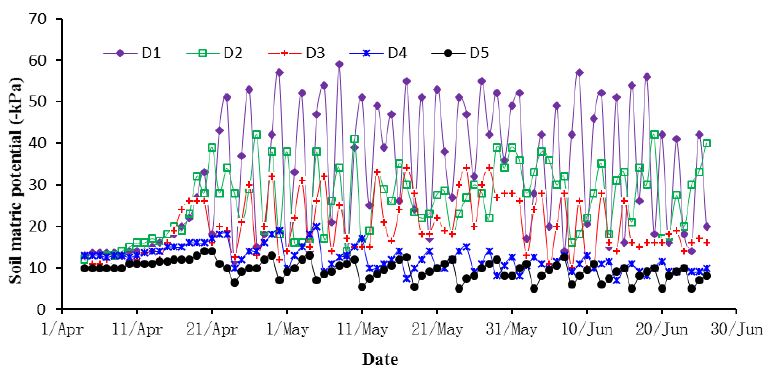
Figure 6. Soil matric potentials near the emitters for the five treatments.